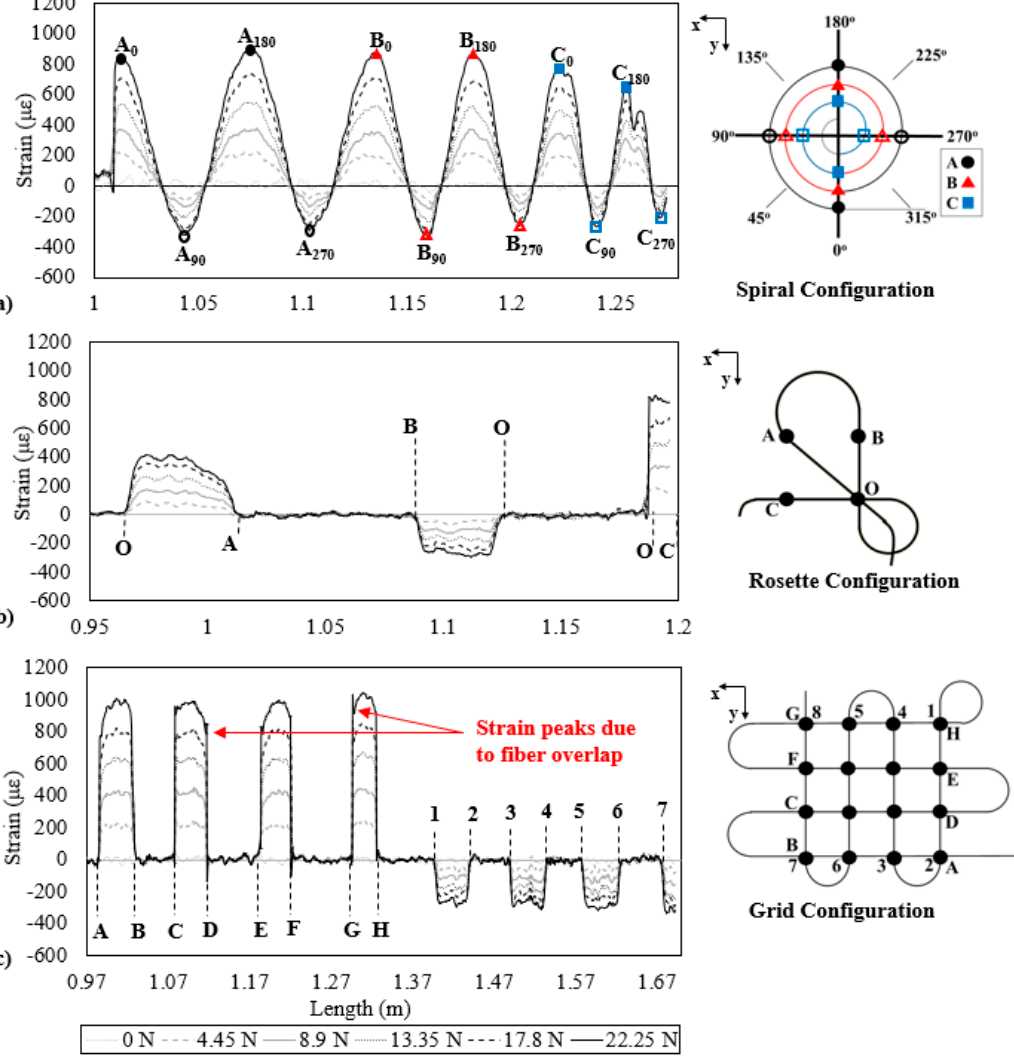
Figure 5. Measured strain along optical fiber length for different applied loads (0 N to 22.25 N) for the ( a ) spiral, ( b ) rosette, and ( c ) grid configurations.